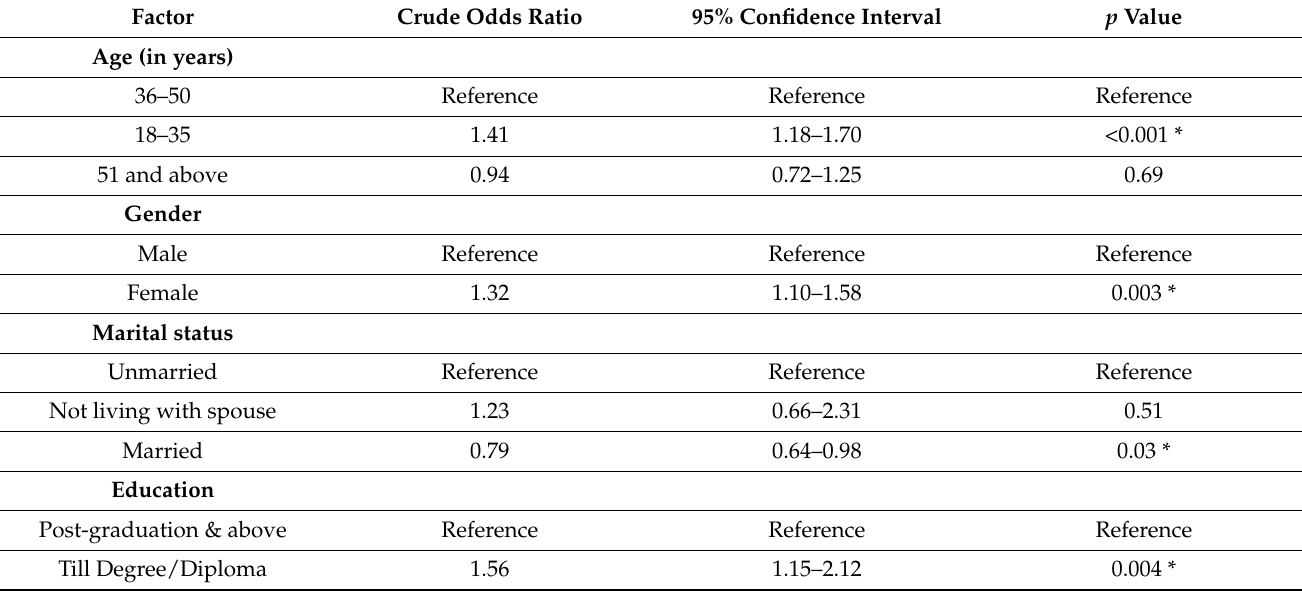
Table 5. Factors associated with increase in life skills among participants (binary logistic